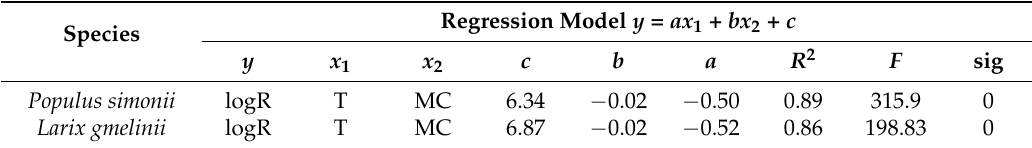
Table 2. Regression models of logR to temperature and moisture content in the sound samples.